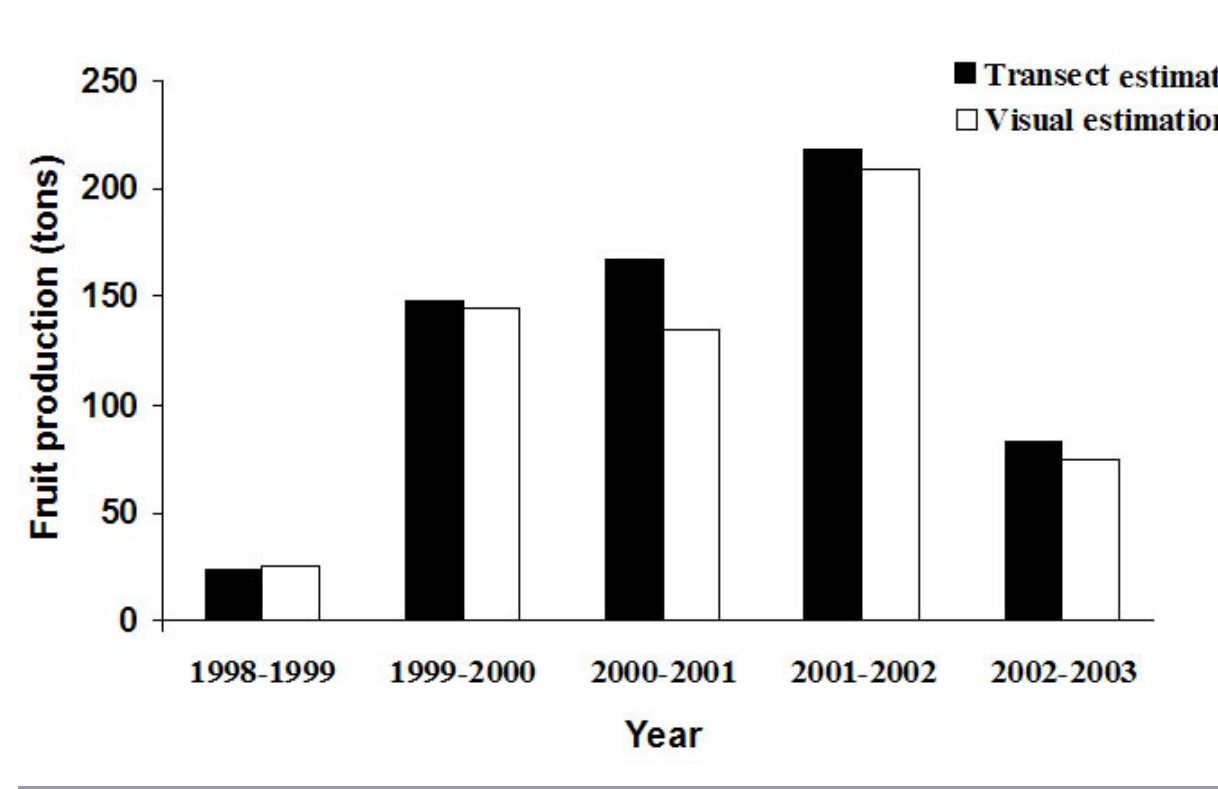
Fig. 4 . Estimation of annual fruit production of amla ( Phyllanthus emblica and P. indofishceri ) based on visual estimations by harvesters vs. transect